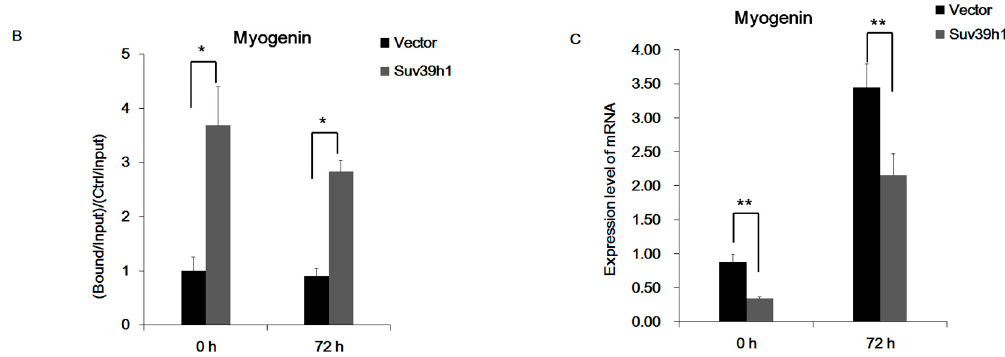
Figure 6. Suv39h1 inhibited MEF2 target gene transactivation. ( A ) C2C12 cells were transiently transfected with expression vectors for Suv39h1 (0.1 to 0.6 µ g), MEF2C (0.2 µ g), HP1 α (0.1 µ g), a MEF2-dependent reporter plasmid (3 × MEF2-luciferase reporter plasmid; 0.1 µ g), and a